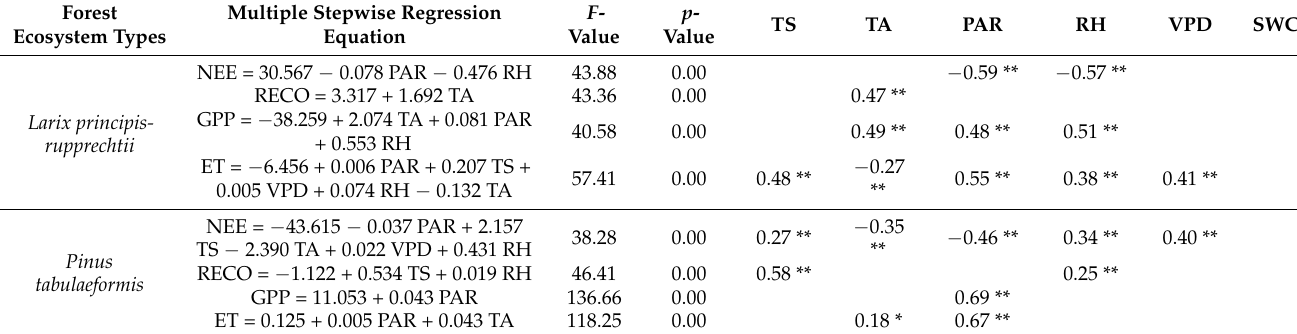
Table 1. Results for the multiple stepwise regression analysis of effects of potential meteorological drivers (TS, TA, PAR, RH, VPD, and SWC) on the CO 2 and H 2 O fluxes (NEP, RECO, GPP, and ET) in two forest ecosystems.